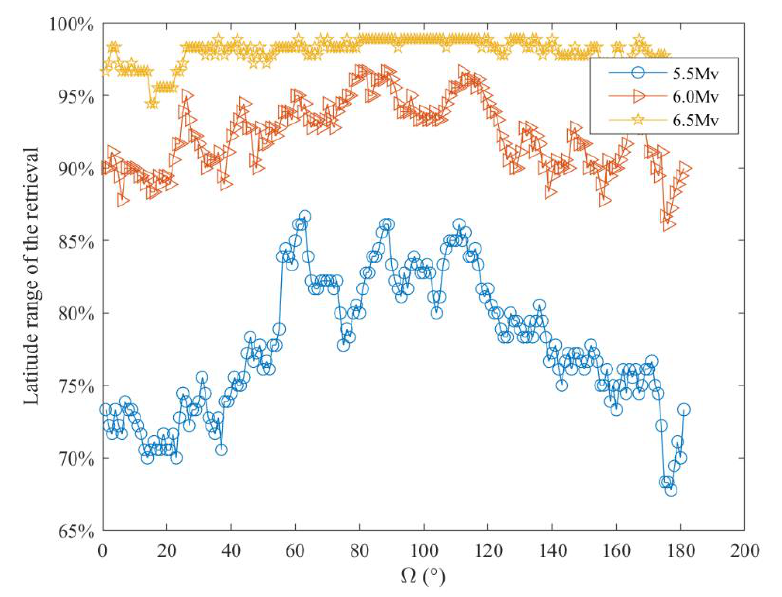
Figure 5. Latitude range of the retrieval with RAAN.